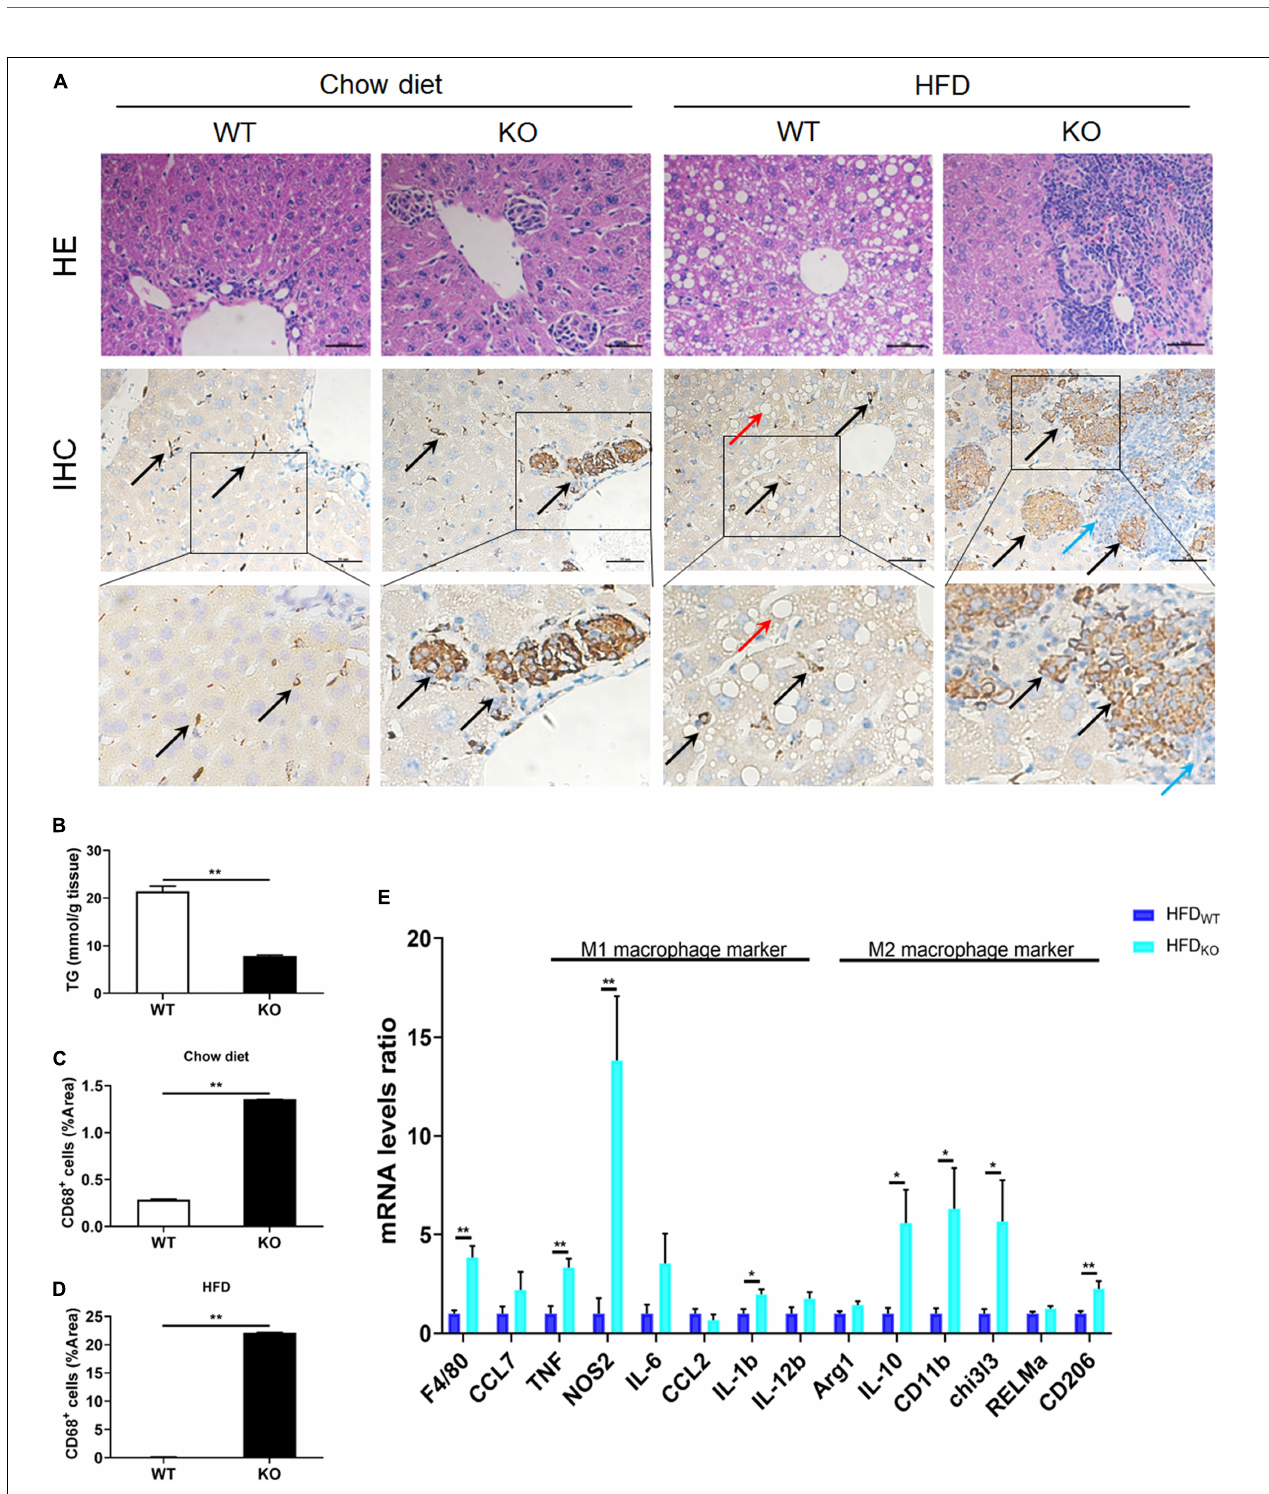
FIGURE 4 | LAMTOR1 MKO attenuates hepatic steatosis and leads to accumulation of macrophages in the central vein area and the portal area. (A) HE and CD68 IHC staining in the liver. Black arrow represents the CD68 + Kupffer cells, red arrow represents the lipid droplets, and blue arrow represents the dead cells. (B) Hepatic TG concentration of HFD-fed WT and KO mice. (C,D) IHC quantification in the context of (C) Chow diet- and (D) HFD-fed mice, presented as the percentage of the area of CD68 + cells. (E) qRT-PCR results of the expression of inflammatory genes. The data expressed as mean ± SEM, n = 4–6. * P < 0.05 vs. WT; ** P < 0.01 vs. WT. HE, hematoxylin & eosin staining; HFD, high-fat diet; IHC, Immunohistochemistry; MKO, myeloid-specific knockout; SEM, standard error of the mean; WT,